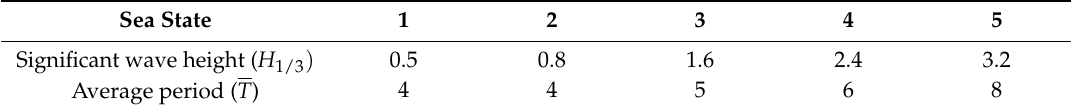
Table 3. Significant wave height and average period for the five sea states.